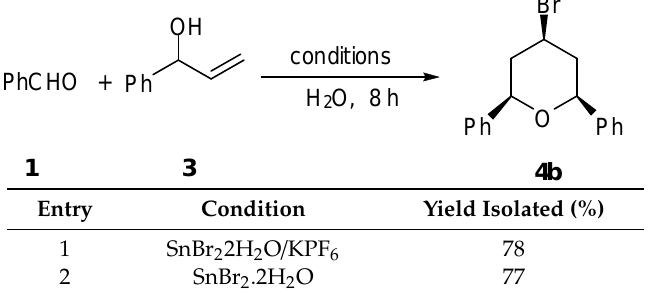
Table 6. Reaction of benzaldehyde (1) with homoallylic alcohol (3) promoted by SnBr 2 .